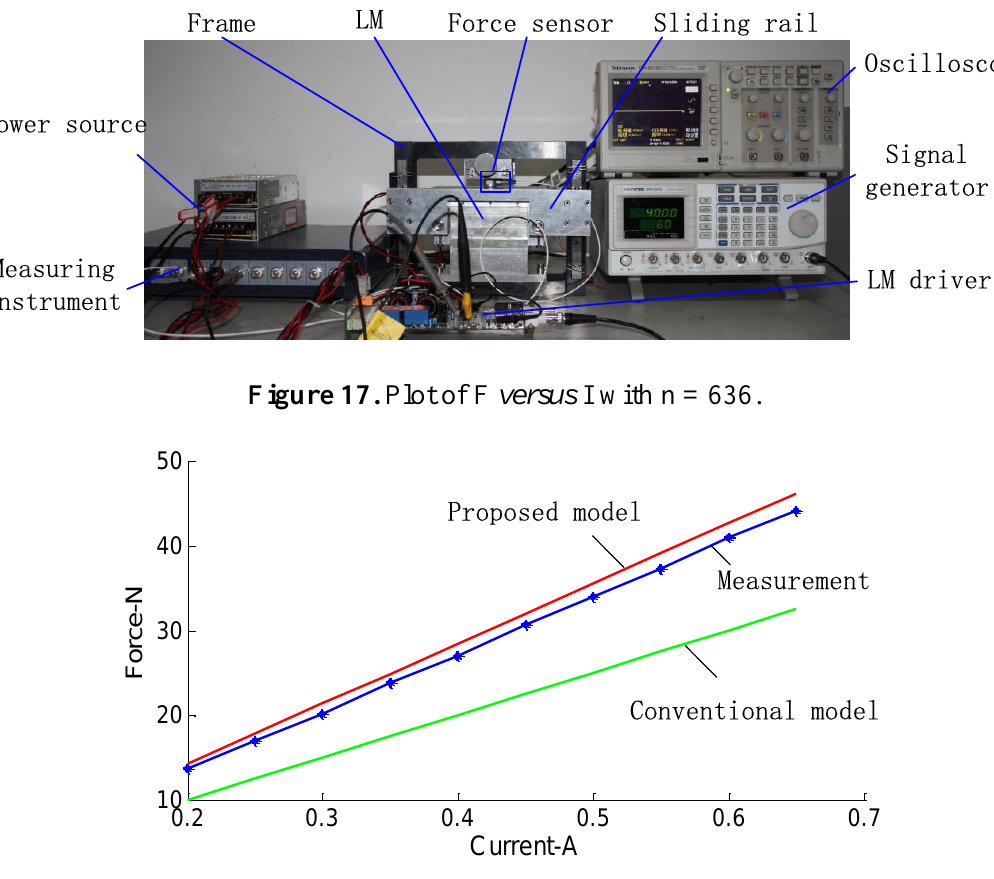
Figure 16. Photo of experimental setup.